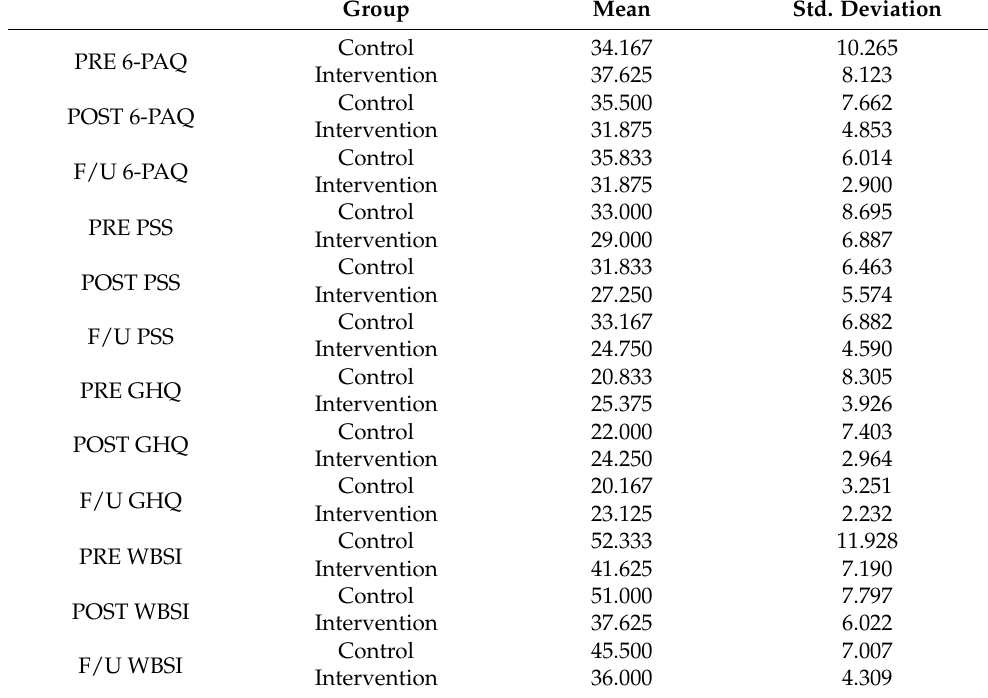
Table 2. Descriptive statistics of questionnaires scores (pre, post, and follow-up) for both groups.